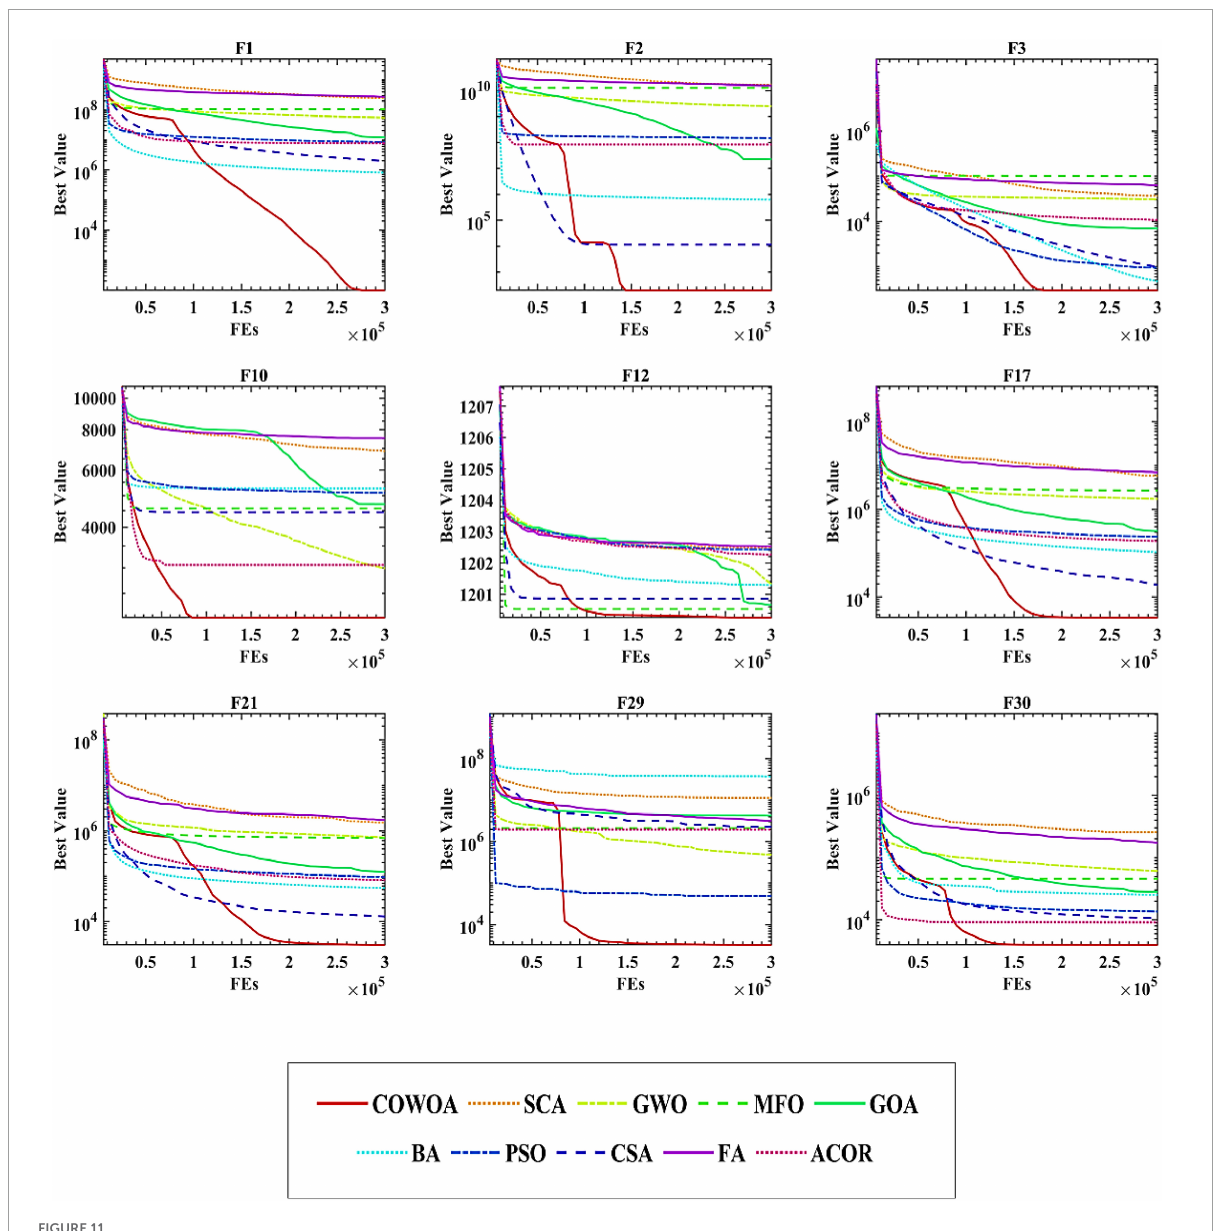
FIGURE11 Convergence curves of COWOA with the well-known original